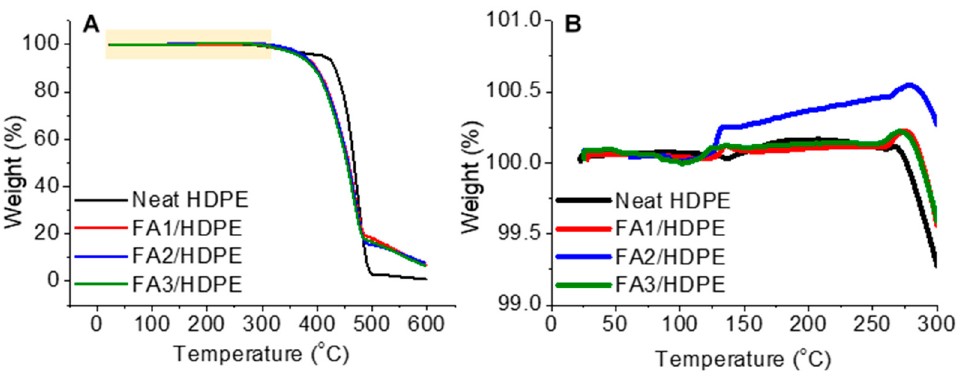
Figure 2. Thermogravimetric degradation of freshly made neat HDPE and FA/HDPE composite samples: ( A ) overall degradation pattern and ( B ) understanding the sample degradation pattern at the temperature near to the melt-processing temperature of the samples of interest.